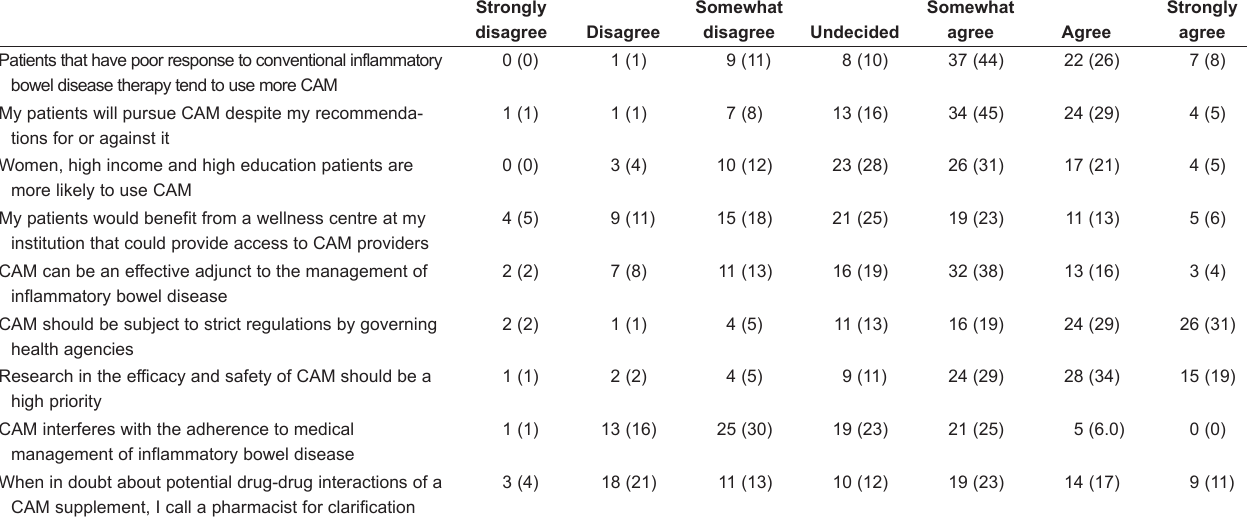
TABLE 3 Perceptions of complementary alternative medicine (CAM) efficacy, user characteristics and utility in patients who use CAM to treat inflammatory bowel disease